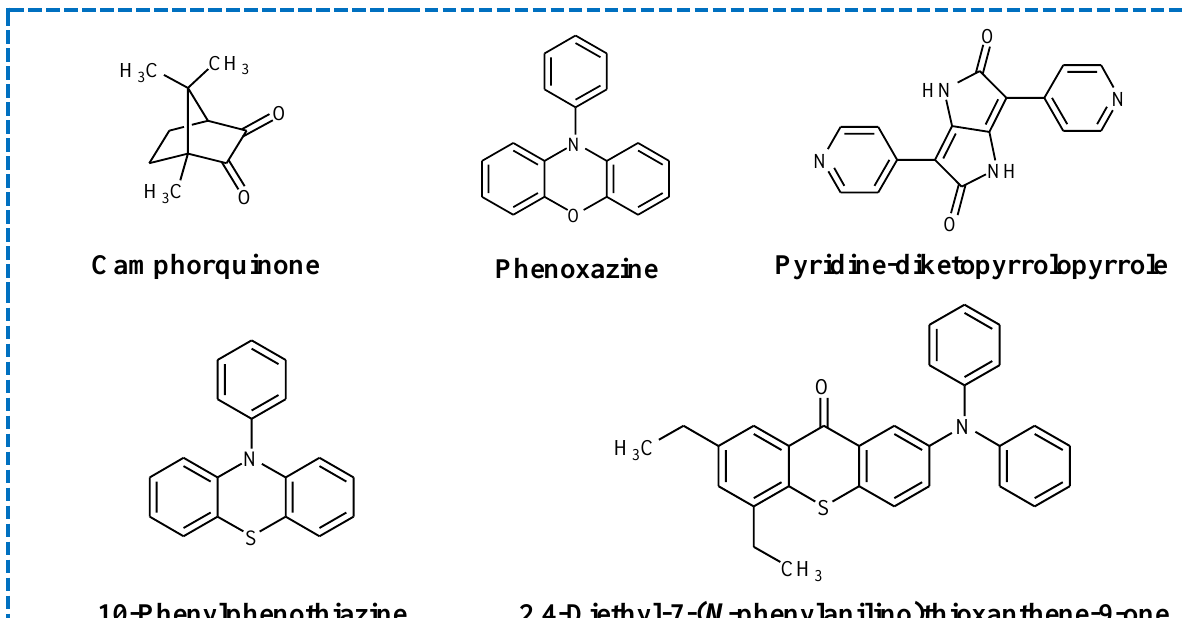
Figure 10. Chemical structures of organic dyes used as photocatalysts for metal-free ATRP processes [102,106,108].